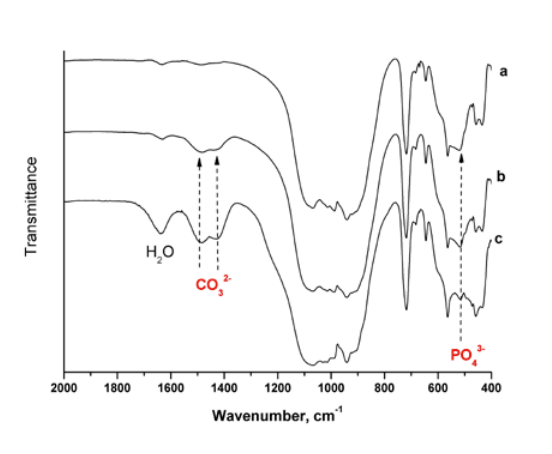
Figure 3. FTIR spectra obtained for CPS-2 before (a) and after 1 day (b) and 3 days (c) soaking in 1.5